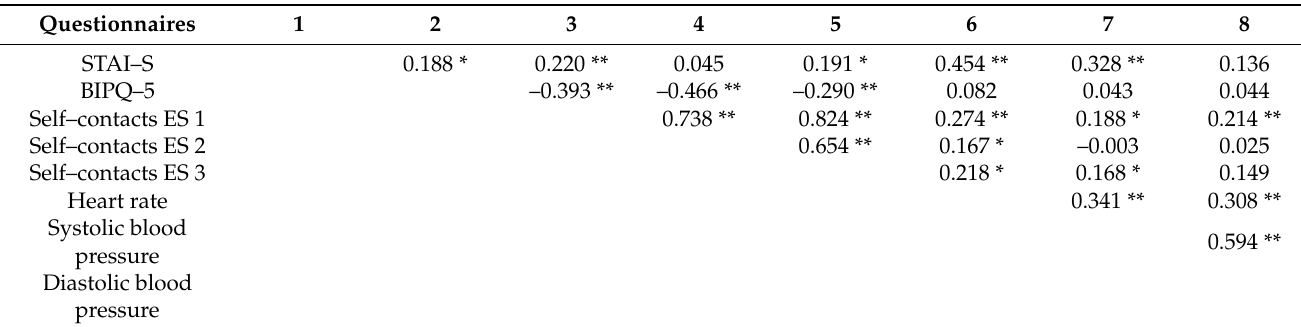
Table 3. Intercorrelations between variables studied (STAI–S, BIPQ–5, Self–contacts/minute Experimental situation 1–2–3, Heart rate/minute, Systolic blood pressure and Diastolic blood pressure) n = 150.